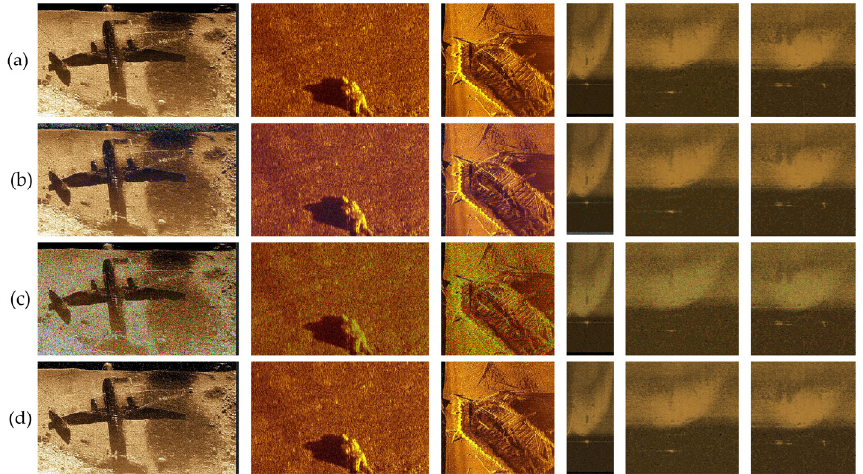
Figure 10. Schematic diagram of adding noise to side-scanning sonar image and front looking sonar image. ( a ) Real image ( b ) Gaussian noise ( c ) Rayleigh noise ( d ) Salt and pepper noise.